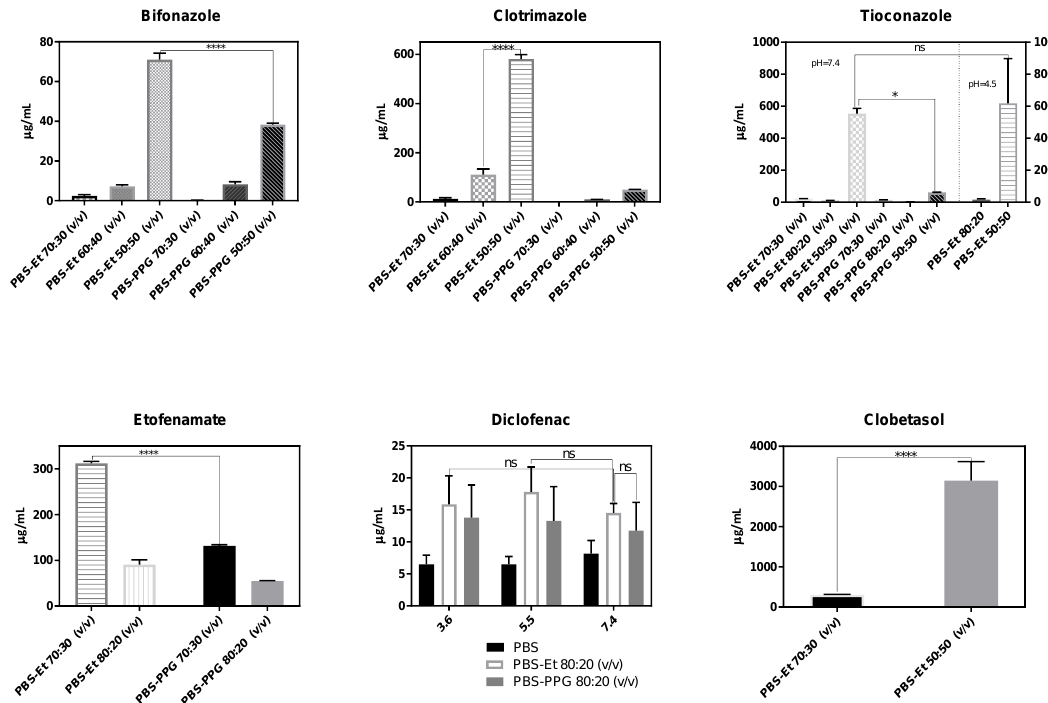
Figure 2. Solubility of the active substances in each medium. The results are expressed as mean ± standard error of the mean (SEM) (4≤n≤7). Since the data are normally distributed (Shapiro-Wilk normality test), a two-way ANOVA with a Tukey multiple comparison test was employed to statistically compare the means. The differences among the means were considered significant for values of p < 0.1. PBS: phosphate based saline; PBS-Et: phosphate based saline/ethanol; PBS-PPG: phosphate based saline/propylenoglycol.